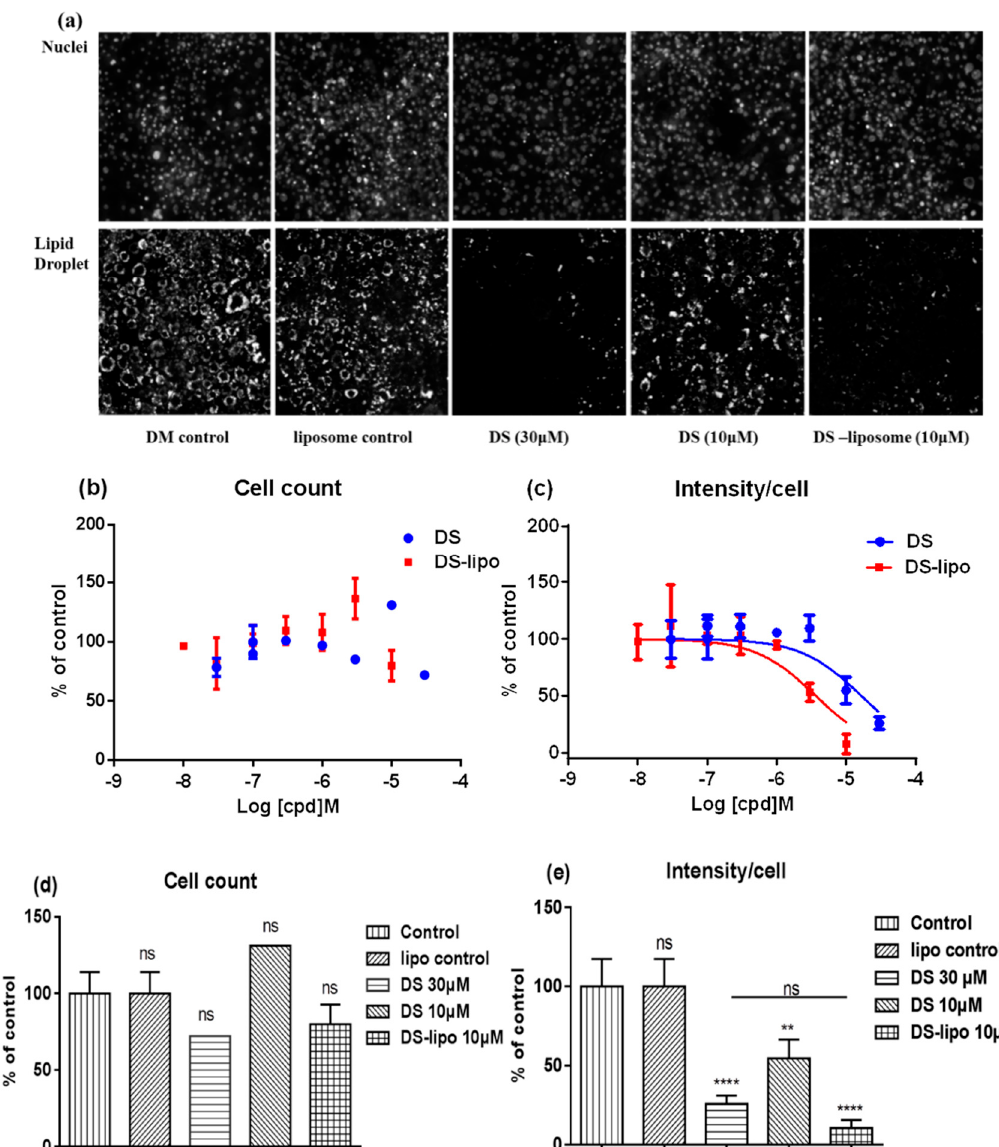
Figure 6. Effect of DS-lipo on lipid droplet formation in 3T3-L1 adipocytes. ( a ) Representative images of cellular lipid droplet and nuclei in 3T3-L1 adipocyte in the presence of DS or DS-lipo. ( b ) Normalized adipocyte cell number treated with various concentrations of DS or DS-lipo. ( c ) Dose response curves of DS and DS-lipo on inhibiting lipid droplet formation. The data was normalized to DM control group and represented mean ±S.D. ( n = 3). ( d ) and ( e ) The statistical analysis of normalized adipocyte cell number and inhibiting lipid droplet formation of DS and DS-lipo at designated concentration. ns p > 0.05, ** p < 0.01, **** p < 0.001.